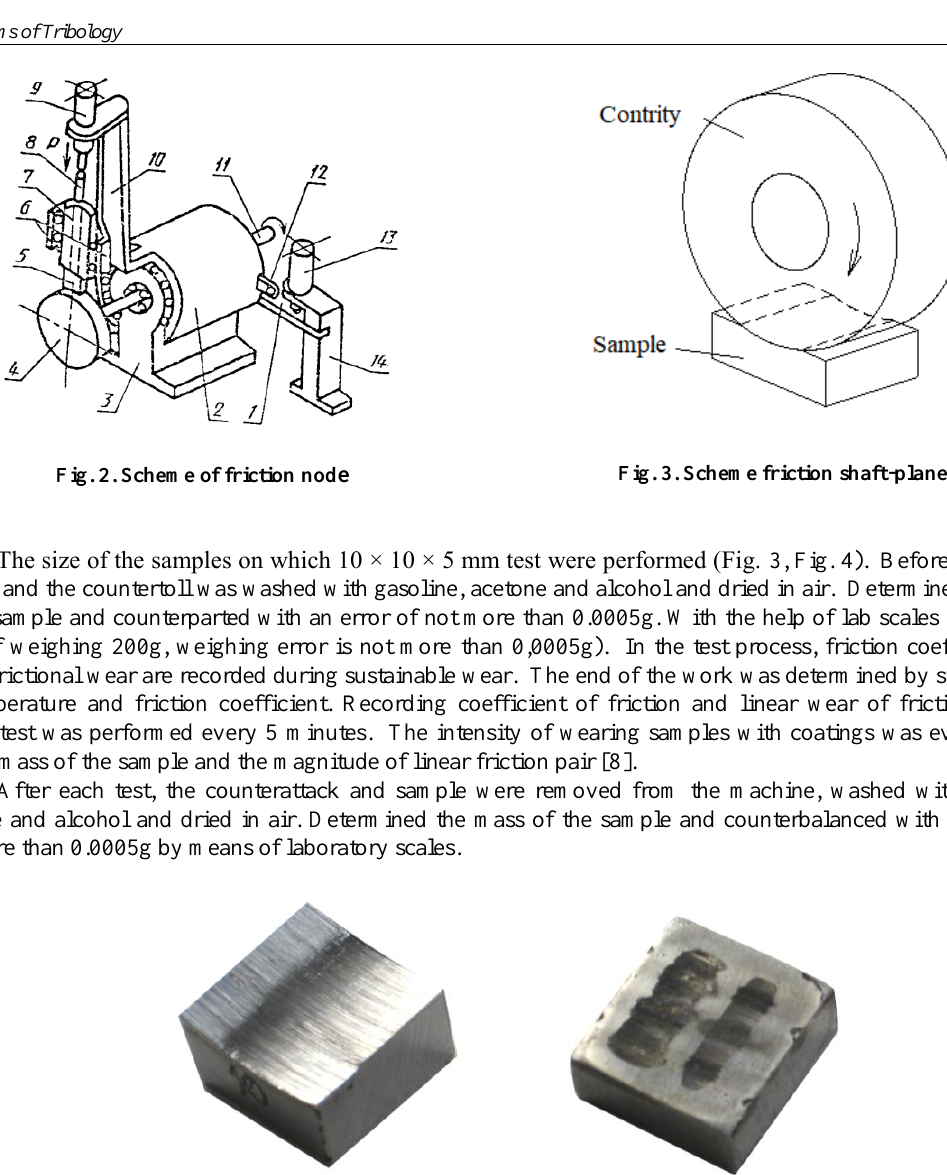
Fig. 4. Samples from a CEC after friction